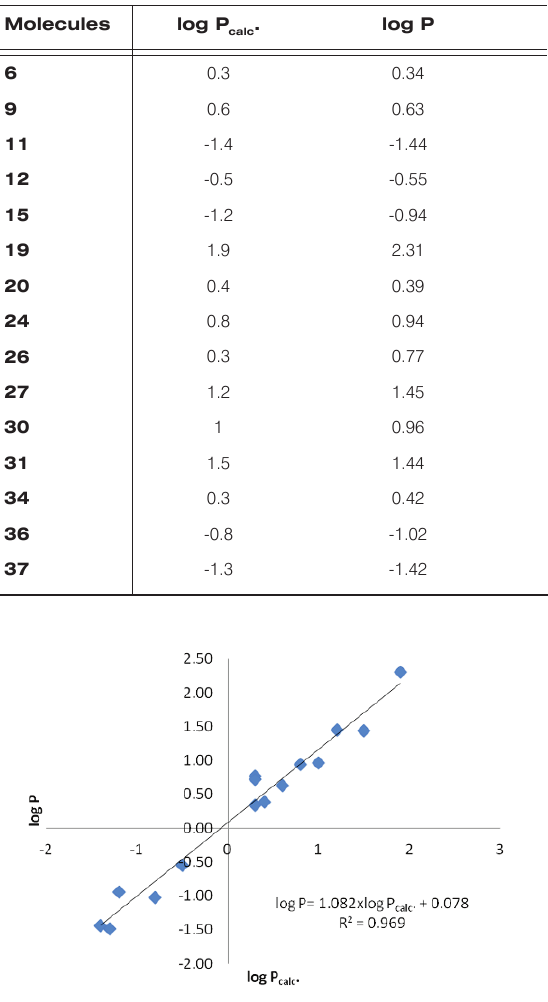
Table 14. Calculated values of log P by similarity clusters for the molecules in the test set. Molecules log P . calc